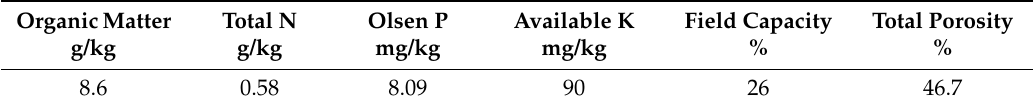
Table 1. Soil physical and chemical characteristics at the experimental